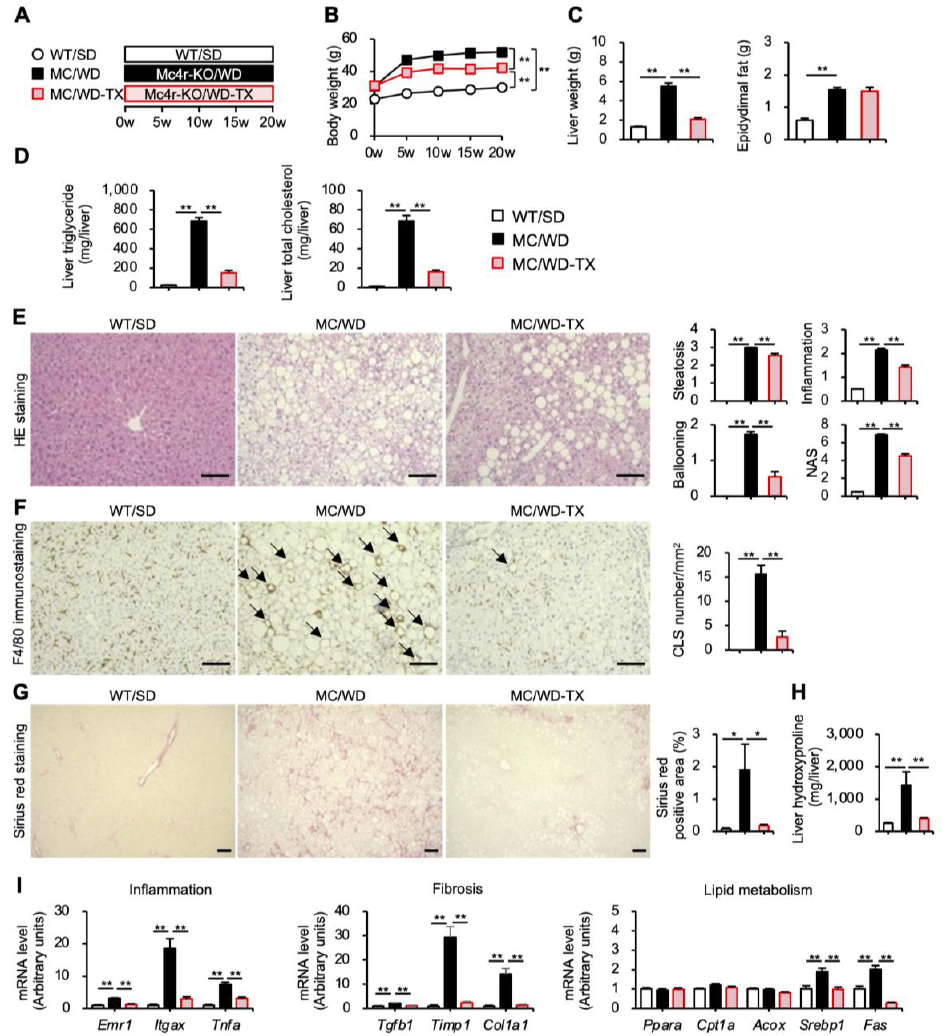
Figure 7. Preventive effects of Taxifolin on the development of NASH in a mouse model. ( A ) Experimental protocol: genetically obese melanocotin-4 receptor ( Mc4r )-deficient mice on a WD with or without 3% Taxifolin for 20 weeks (MC/WD or MC/WD-TX, respectively). Wild-type mice on a standard diet for 20 weeks (WT/SD) were used as a control. ( B ) Growth curve: C-I 3 groups – white square, WT/SD; black square, MC/WD; light-red square, MC/WD-TX. ( C ) Liver and epididymal fat weights. ( D ) Hepatic triglyceride and total cholesterol contents. ( E ) HE staining of the liver. Histological analysis using the nonalcoholic fatty liver disease (NAFLD) activity score (NAS) system. ( F ) F4/80 immunostaining. The arrows indicate the crown-like structures (CLS). ( G ) Sirius red staining. ( H ) Hydroxyproline contents of the liver. ( I ) Expression levels of genes related to inflammation ( Emr1 , Itgax , and Tnfα ), fibrosis ( Tgfb1 , Timp1 , and Col1a1 ), and lipid metabolism ( Ppara , Cpt1a , Acox , Srebp1 , and Fas ). Scale bars: 100 µm. Values are presented as the means ± SEM; n = 11 – 12; significant differences: * p < 0.05 and ** p < 0.01.